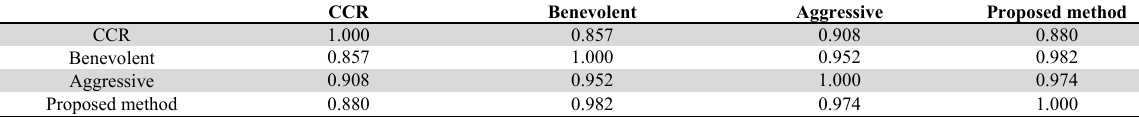
The correlation test for fourteen international passenger airlines